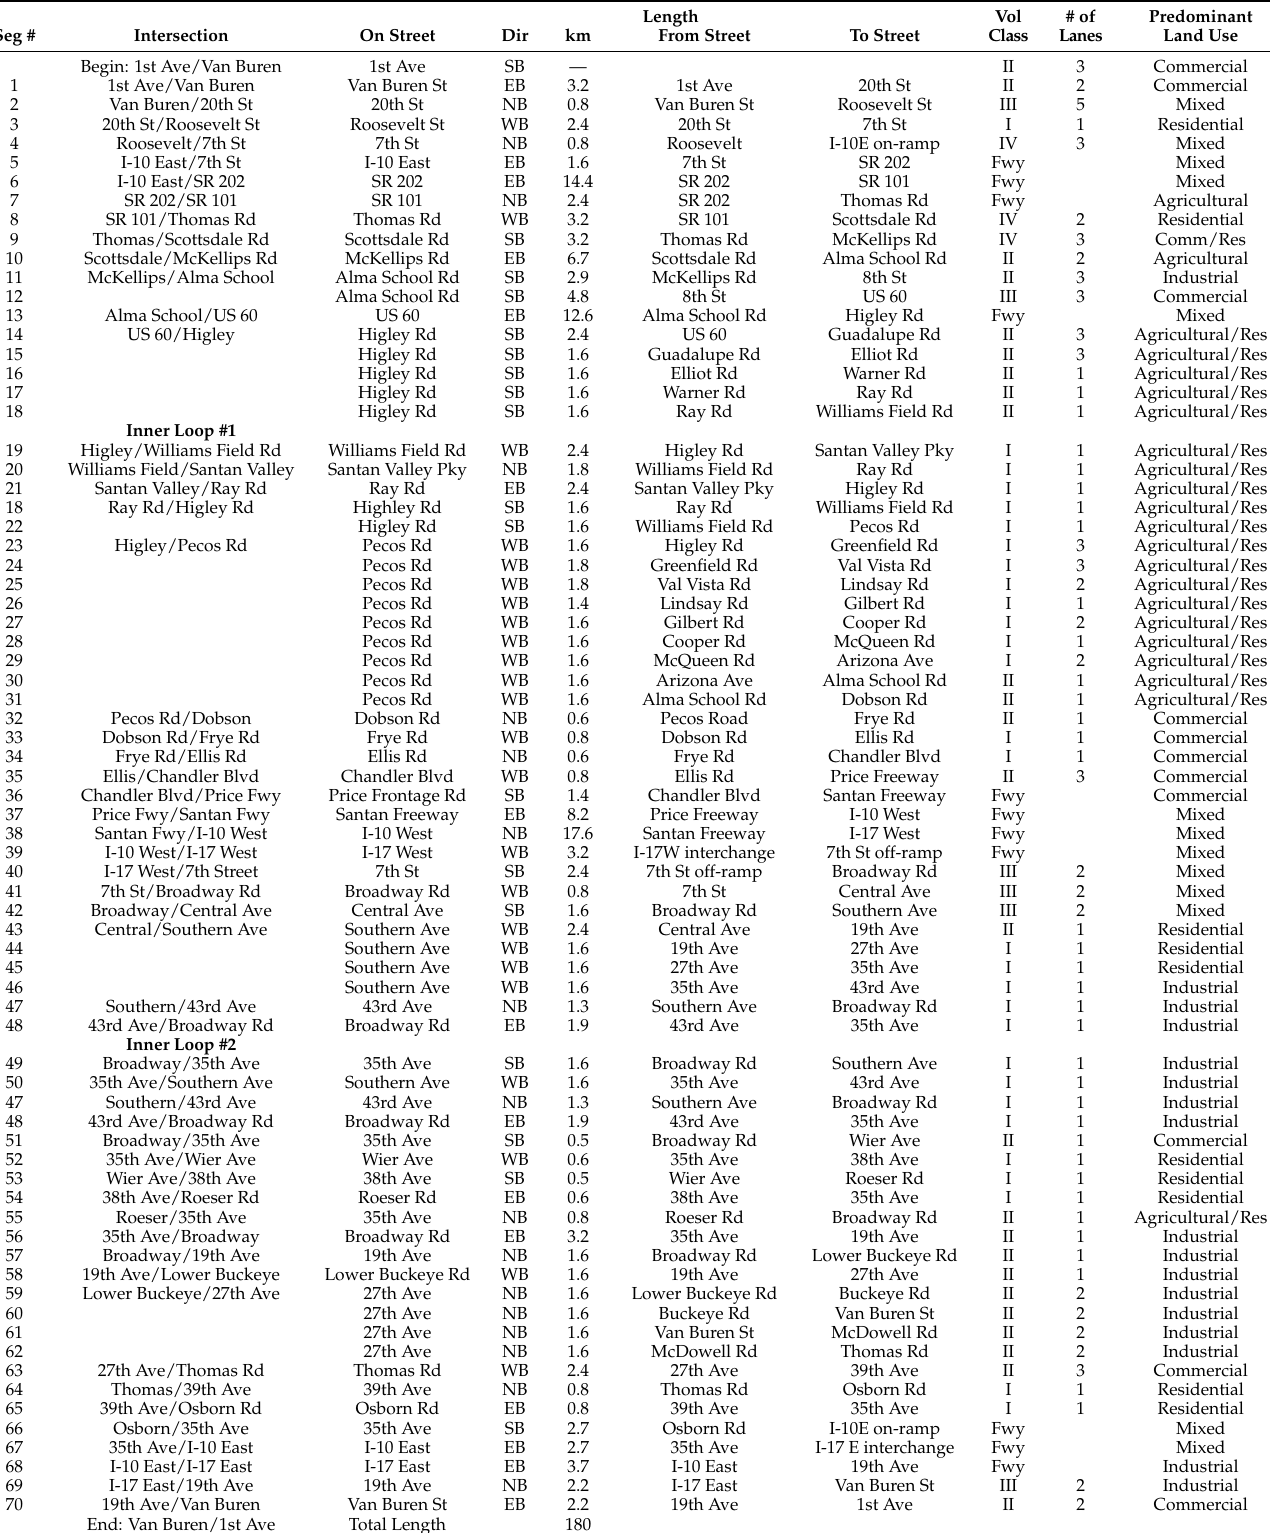
Table 1. List of test route segments and road classification